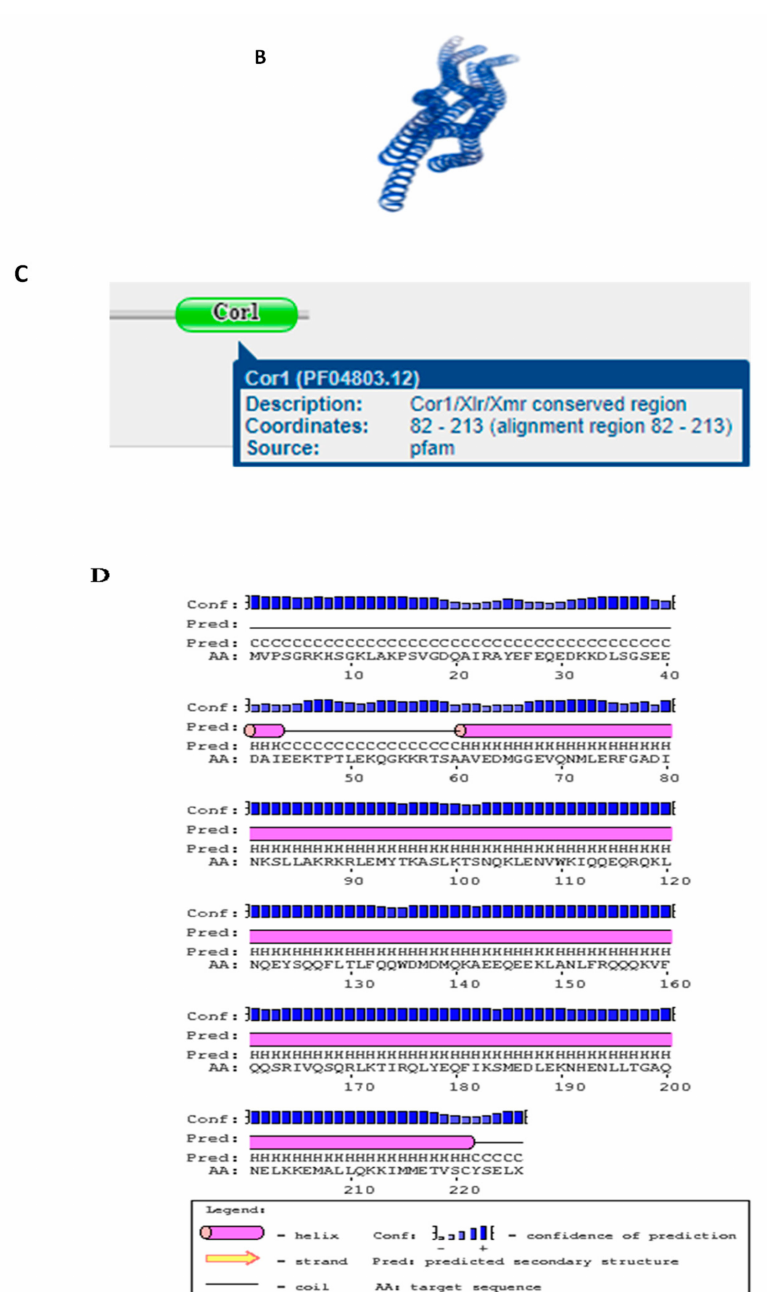
Figure 5. The predicated protein sequence coded by SYCP3 of yak using di ff erent bioinformatics tools. The protein encoded by SYCP3 comprised of Cor1 / Xlr / Xmr conserved regions. ( A ). The predicated protein sequence from yak SYCP3 gene. ( B ) projected three dimensional structures of SYCP3. ( C ) anticipated conserved domain for the protein encoded by SYCP3. ( D ) estimated secondary structures of